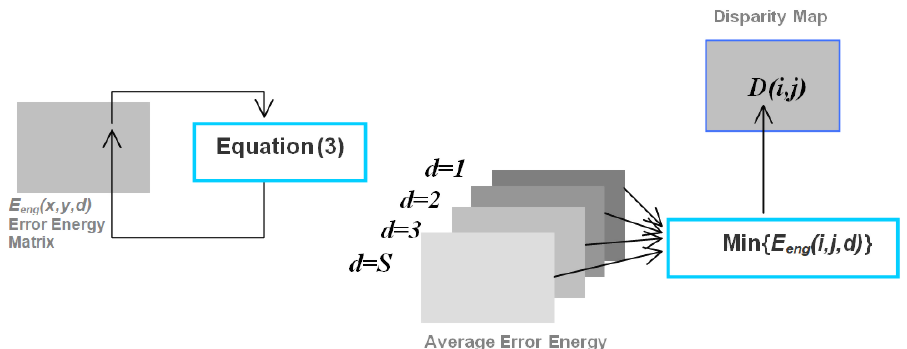
Figure 4. Estimation of the disparity map from the minimum of smoothed error